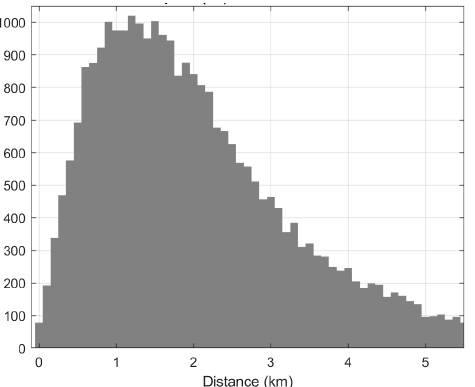
Figure A1. Histogram of the distance between low-pass filtered (hamming 36 h, sampled every 6 h) and interpolated (every 0.5 h) drifter positions, using the entire CALYPSO drifter dataset in the southwestern Mediterranean Sea.